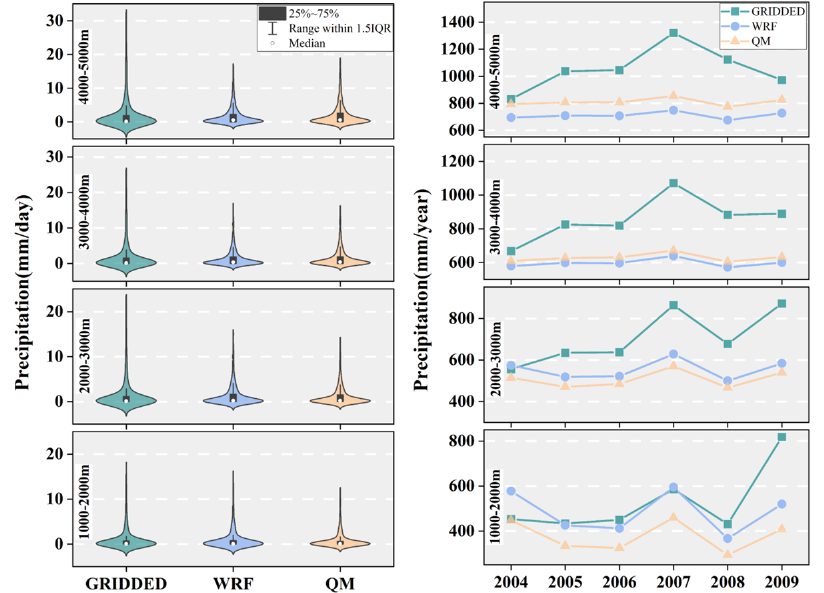
Figure 4. The left is the altitude-related frequency distribution of precipitation datasets (the GRIDDED precipitation, the WRF downscaled precipitation, and the QM frequency-corrected precipitation data), and the right is the corresponding annual precipitation trend at different altitudes. The IQR used in the legend of the precipitation frequency map denotes interquartile